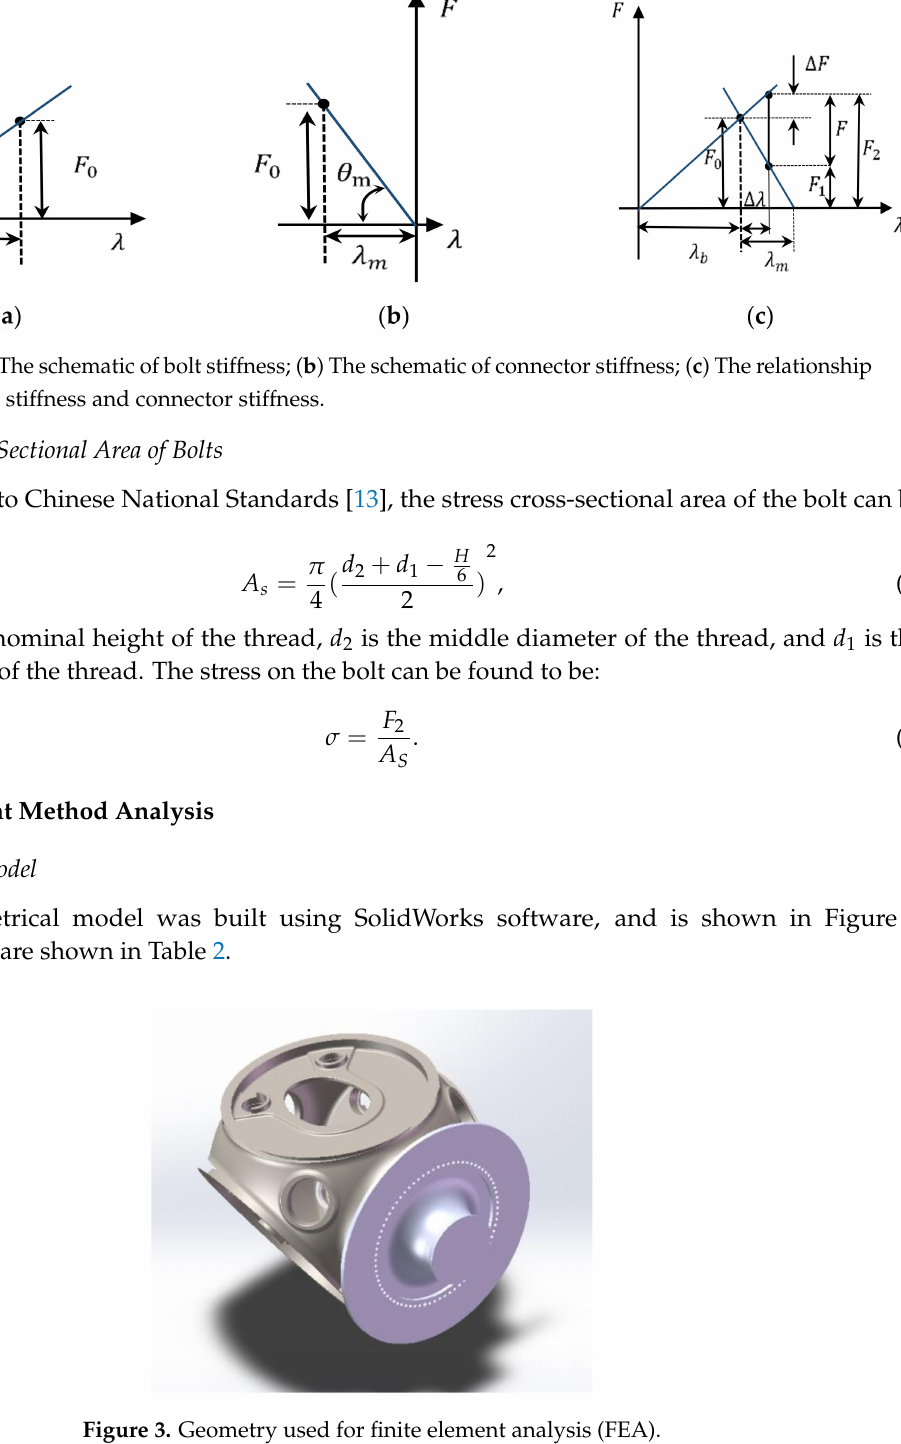
Figure 3. Geometry used for finite element analysis